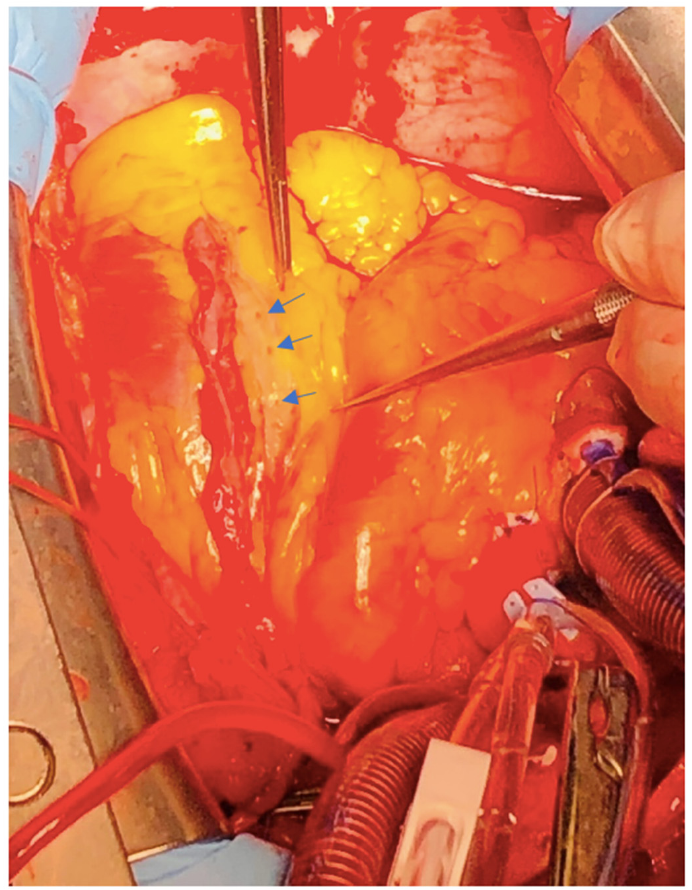
Figure 2. Adventitia of the left anterior descending artery after plaque extraction. Several origins of septal branches can be observed (blue arrows). Left ITA harvested in a skeletonized fashion is prepared for termino ‐ lateral anastomosis.